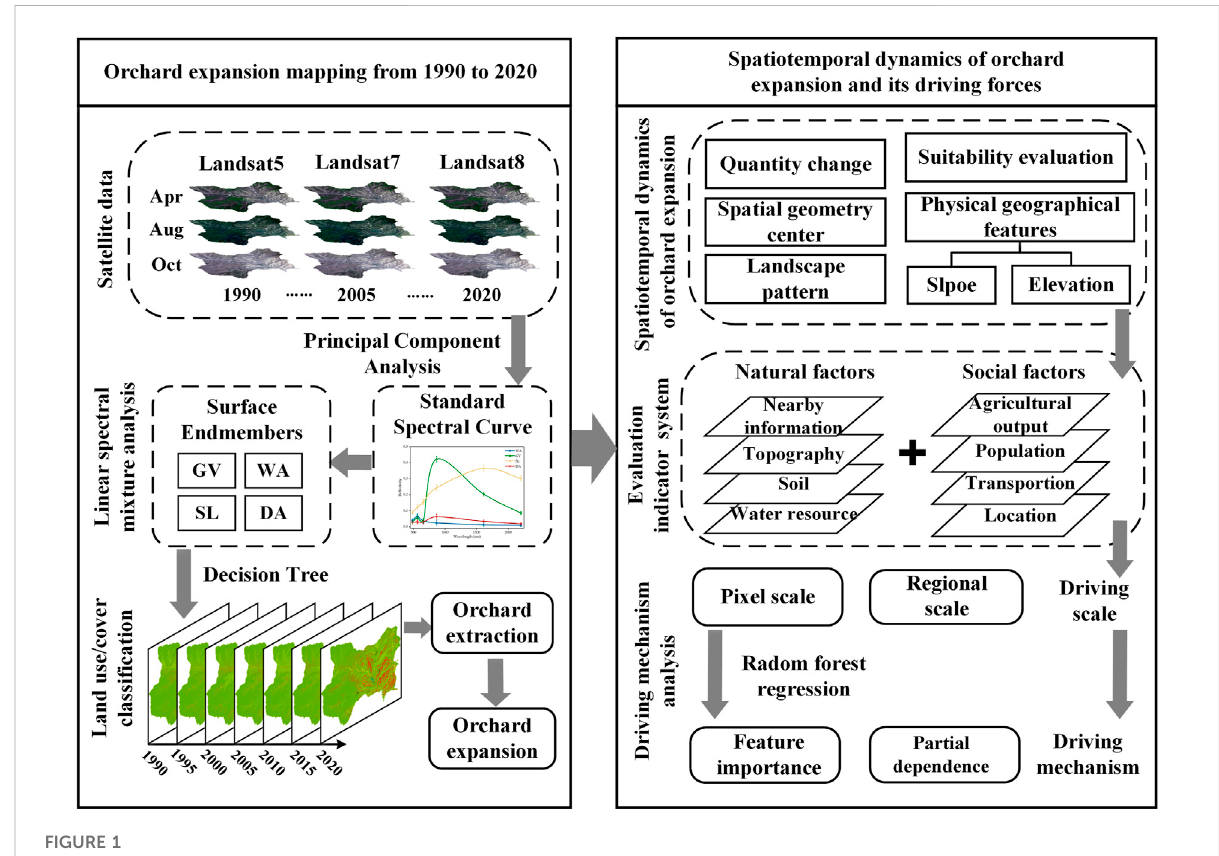
FIGURE 1 Overall work fl ow of the